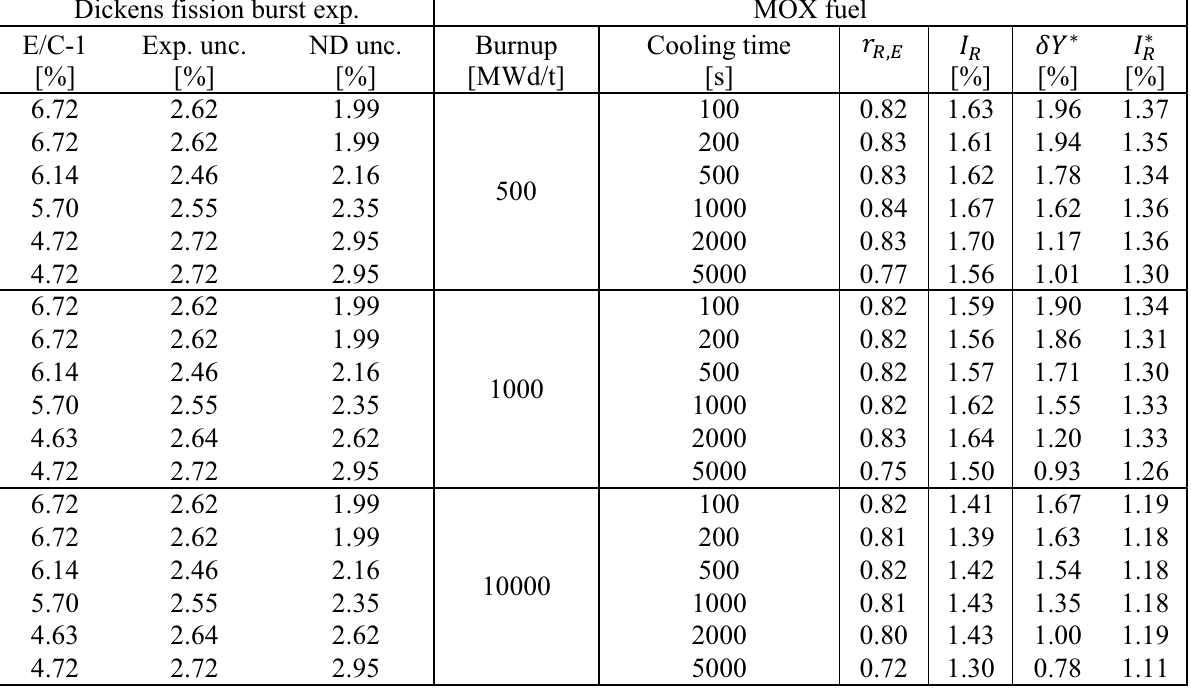
Table II. Transposition results – FY correlated Dickens fission burst